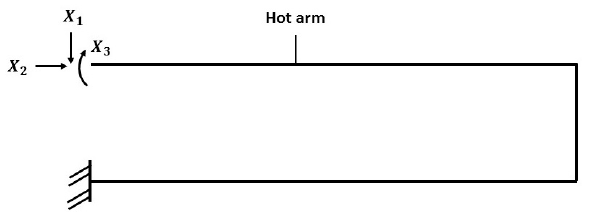
Figure 6. Rigid structure simplified for the electrothermal actuator regarding three redundant forces and moments ( X 1 , X 2 and X 3 ).